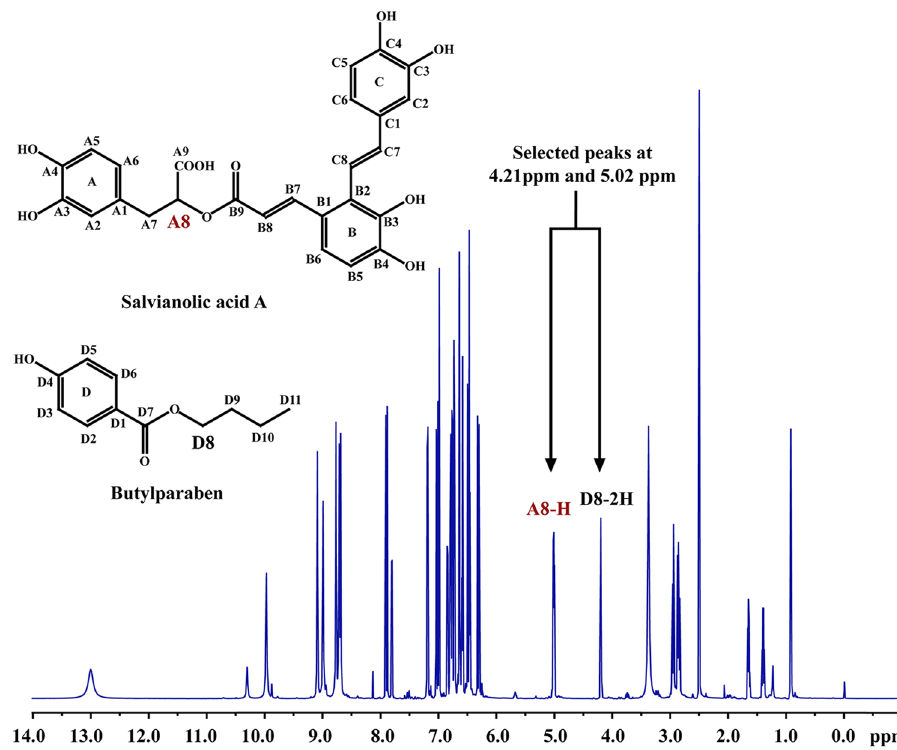
Fig. 3 Quantitative 1 H-NMR spectrum of Sal A with BPB internal